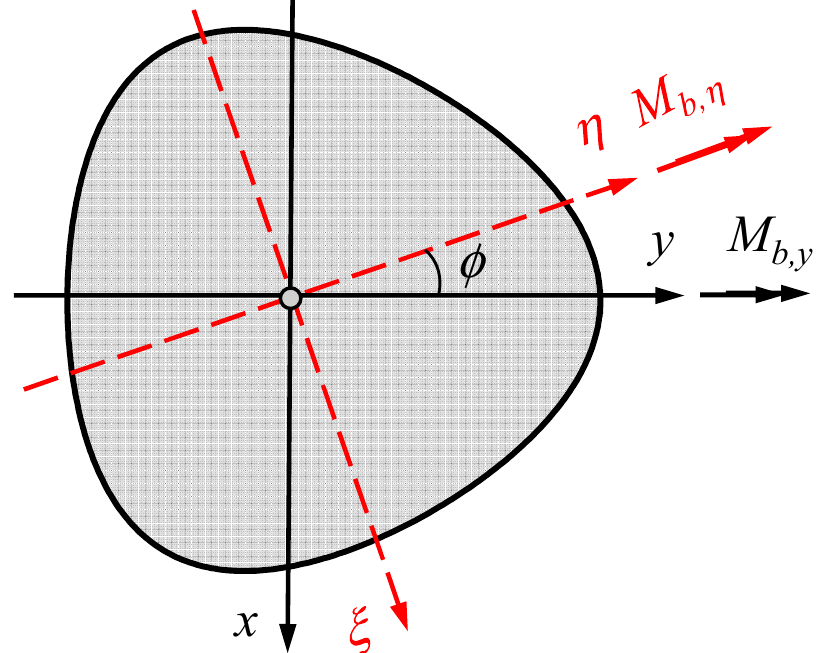
Figure 11. Rotated coordinate system for determining the bending moment of inertia.